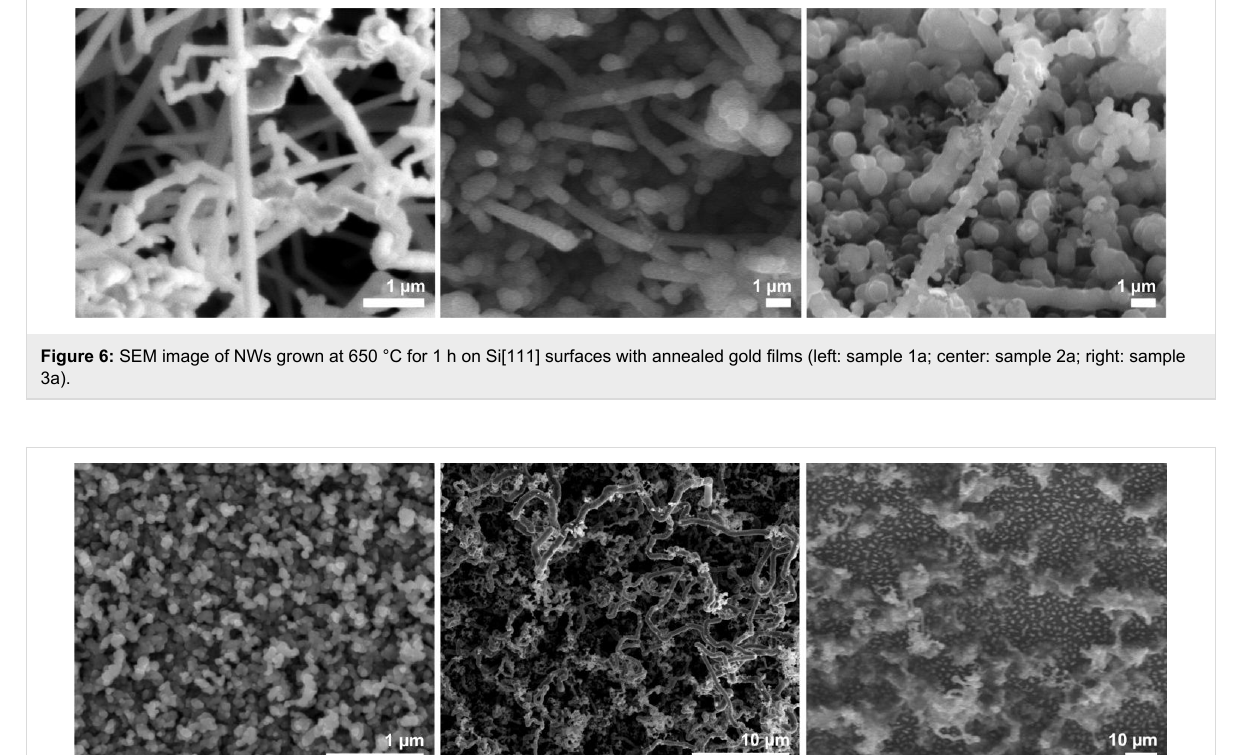
(Figure 6, center). In both cases the diameters of all NWs were more than twice the size of the nanoparticles. The NWs on sample 3a, on which no nanoparticles had been formed during the annealing step, were even bulkier than the ones on the other samples, with a diameter of around 800 nm or more (Figure 6, right). Remarkably, these NWs showed significant